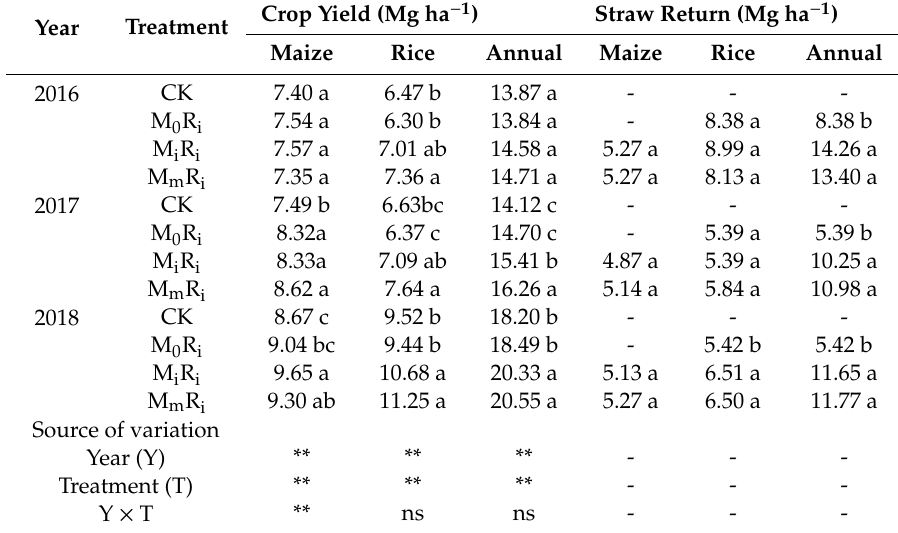
Table 5. Crop yield and amount of straw return for maize and rice crops with di ff erent straw incorporation treatments from 2016 to